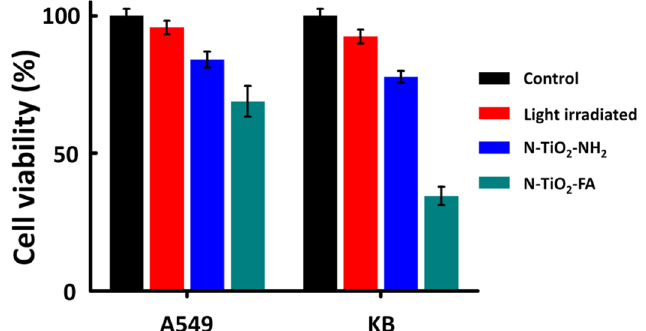
Figure 5. Photokilling effects of N-TiO 2 -FA (green) and N-TiO 2 -NH 2 (blue) with the concentration of 200 μ g·mL − 1 on A549 and KB cells. The control group (black) and light irradiated group (red) were also shown for comparison. Data are expressed as mean ± SD ( n = 4).